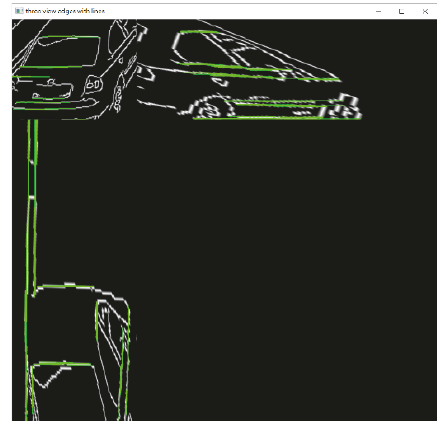
Figure 44: Extraction result of the line of suv.